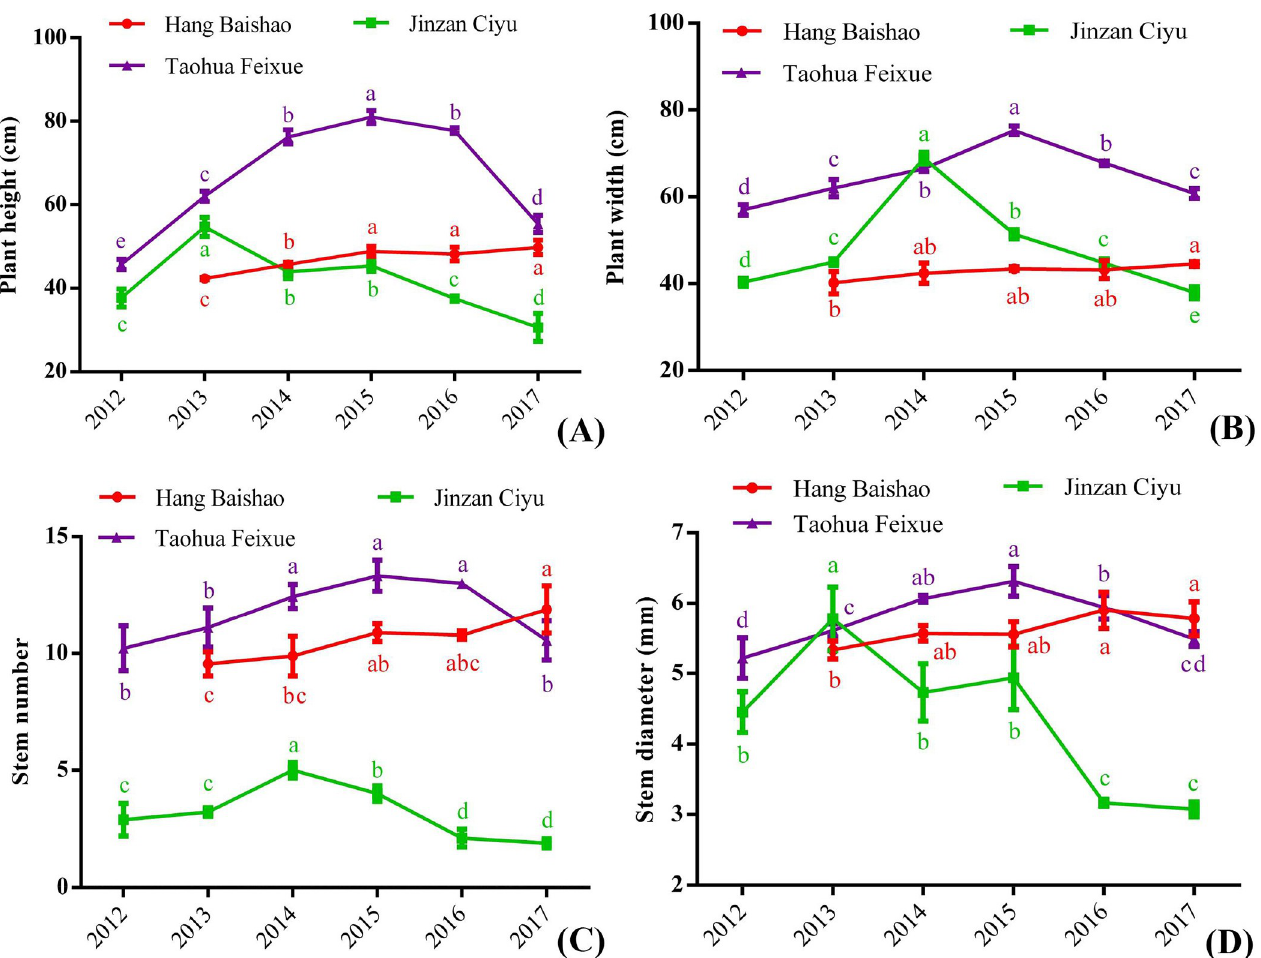
Fig 4. Observation and comparison of the growth performance of three cultivars over six years. The error bars represent the standard deviation, and significance levels are 0.05 in all figures and tables of this study. ‘Hang Baishao’ crowns were introduced and planted in autumn of 2012 for the first time, so all the data related to ‘Hang Baishao’ were recorded from 2013 onward. These will not be repeated in the footnotes of the following figures and tables.